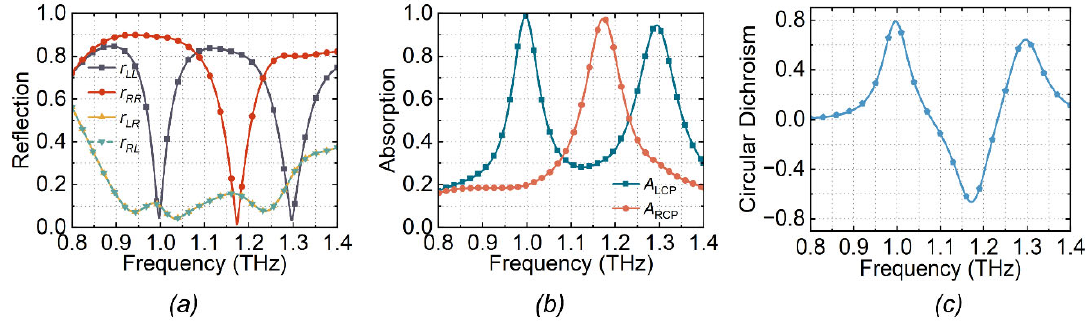
Figure 2. Simulation results of SSA effect of the T ‐ SRR unit cell. ( a ) Reflection coefficient of the T ‐ SRR; ( b ) Absorption of the LCP and RCP waves of the T ‐ SRR; ( c ) Circular dichroism of the T ‐ SRR.